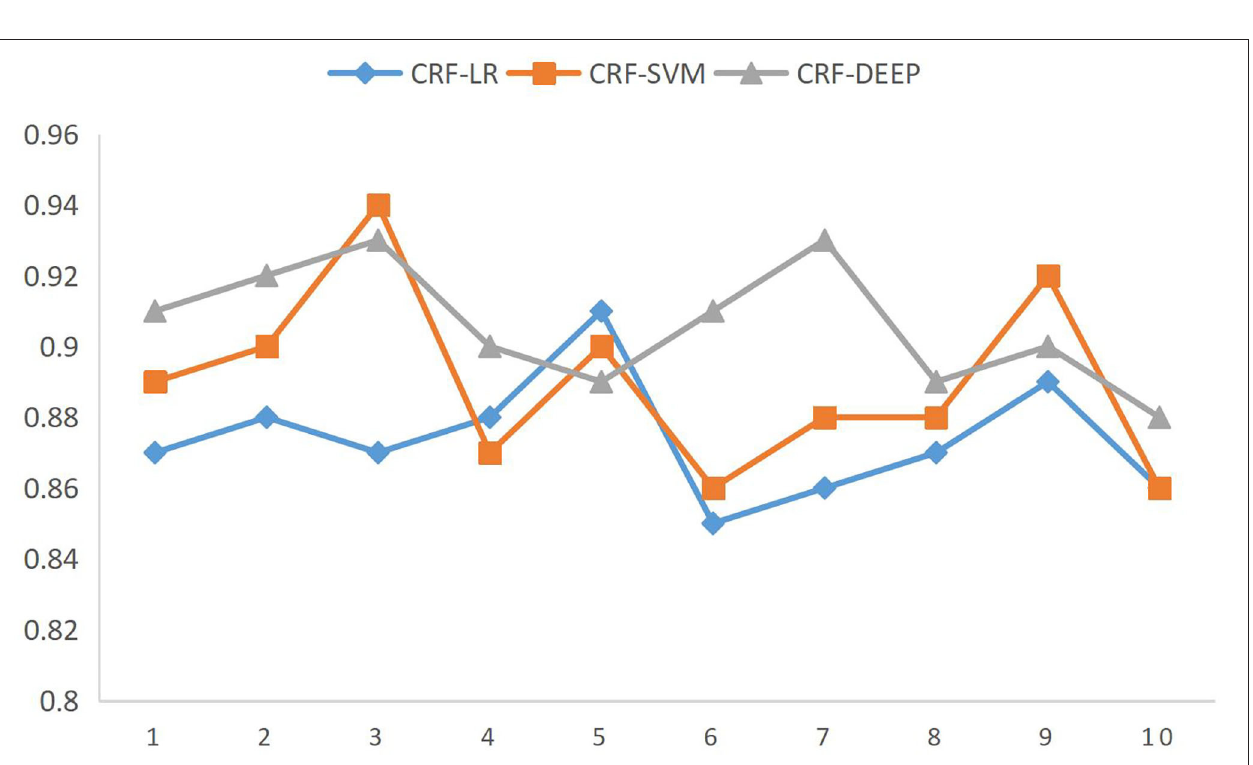
FIGURE 5 | Ten-fold cross-validation accuracy comparison